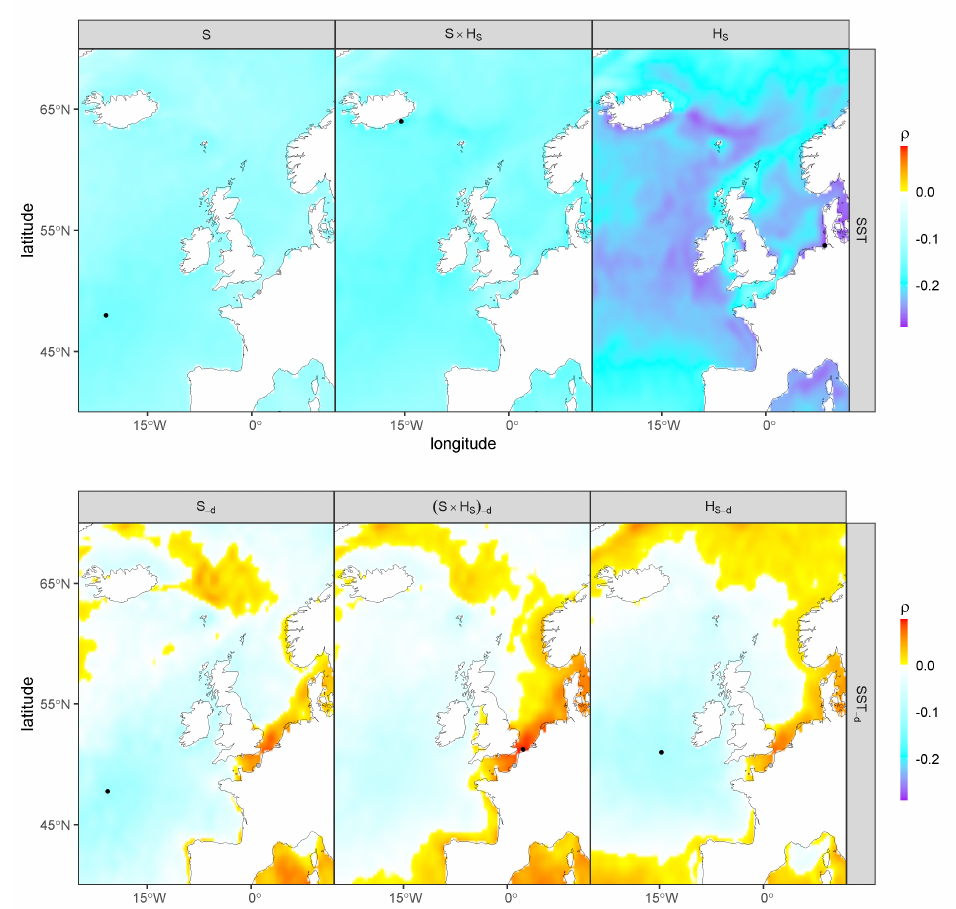
Figure 4. Similar to Figure 3 between the full variables and the covariate field SST (top) and their residuals (with the season removed, bottom). Note that the color scale is different than that in Figure 3, as the correlations with SST and SST − d are much